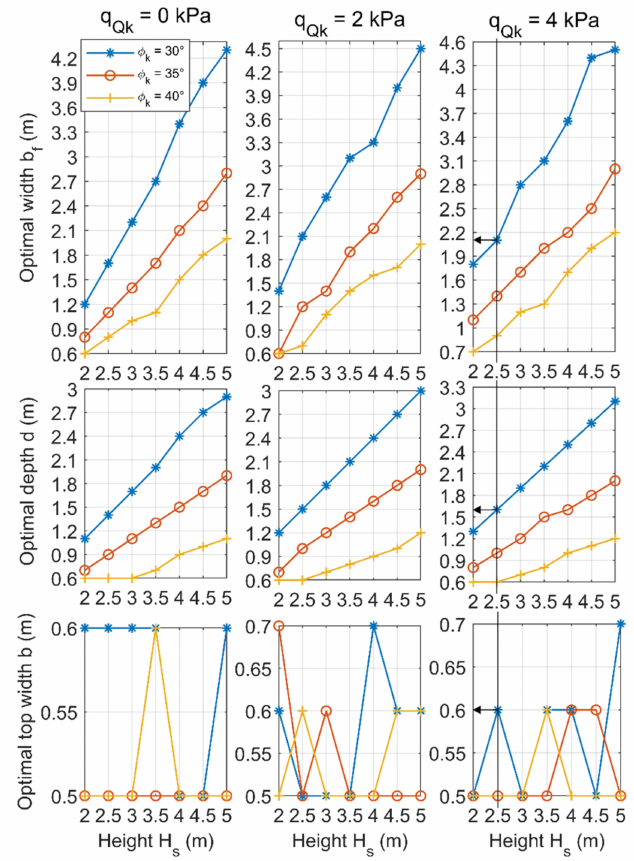
Figure 3. Optimal design for k = 0.5, β = 20 ◦ and γ = 18 kN/m 3